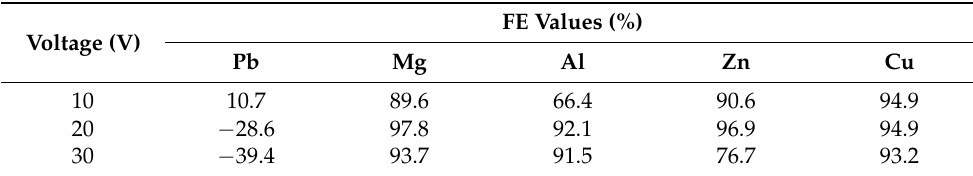
Table 2. FE values after 20 min of electrocoagulation.